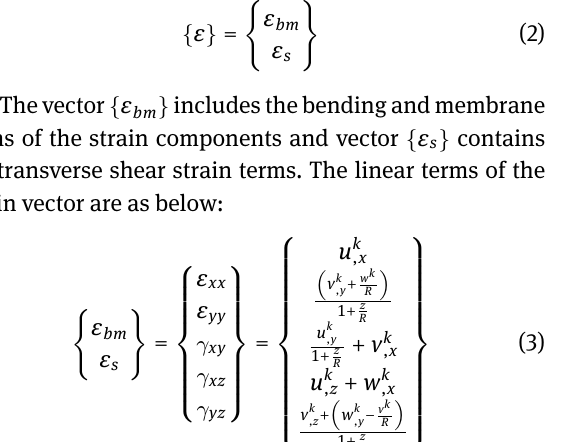
Figure 1: Sandwich cylindrical panel